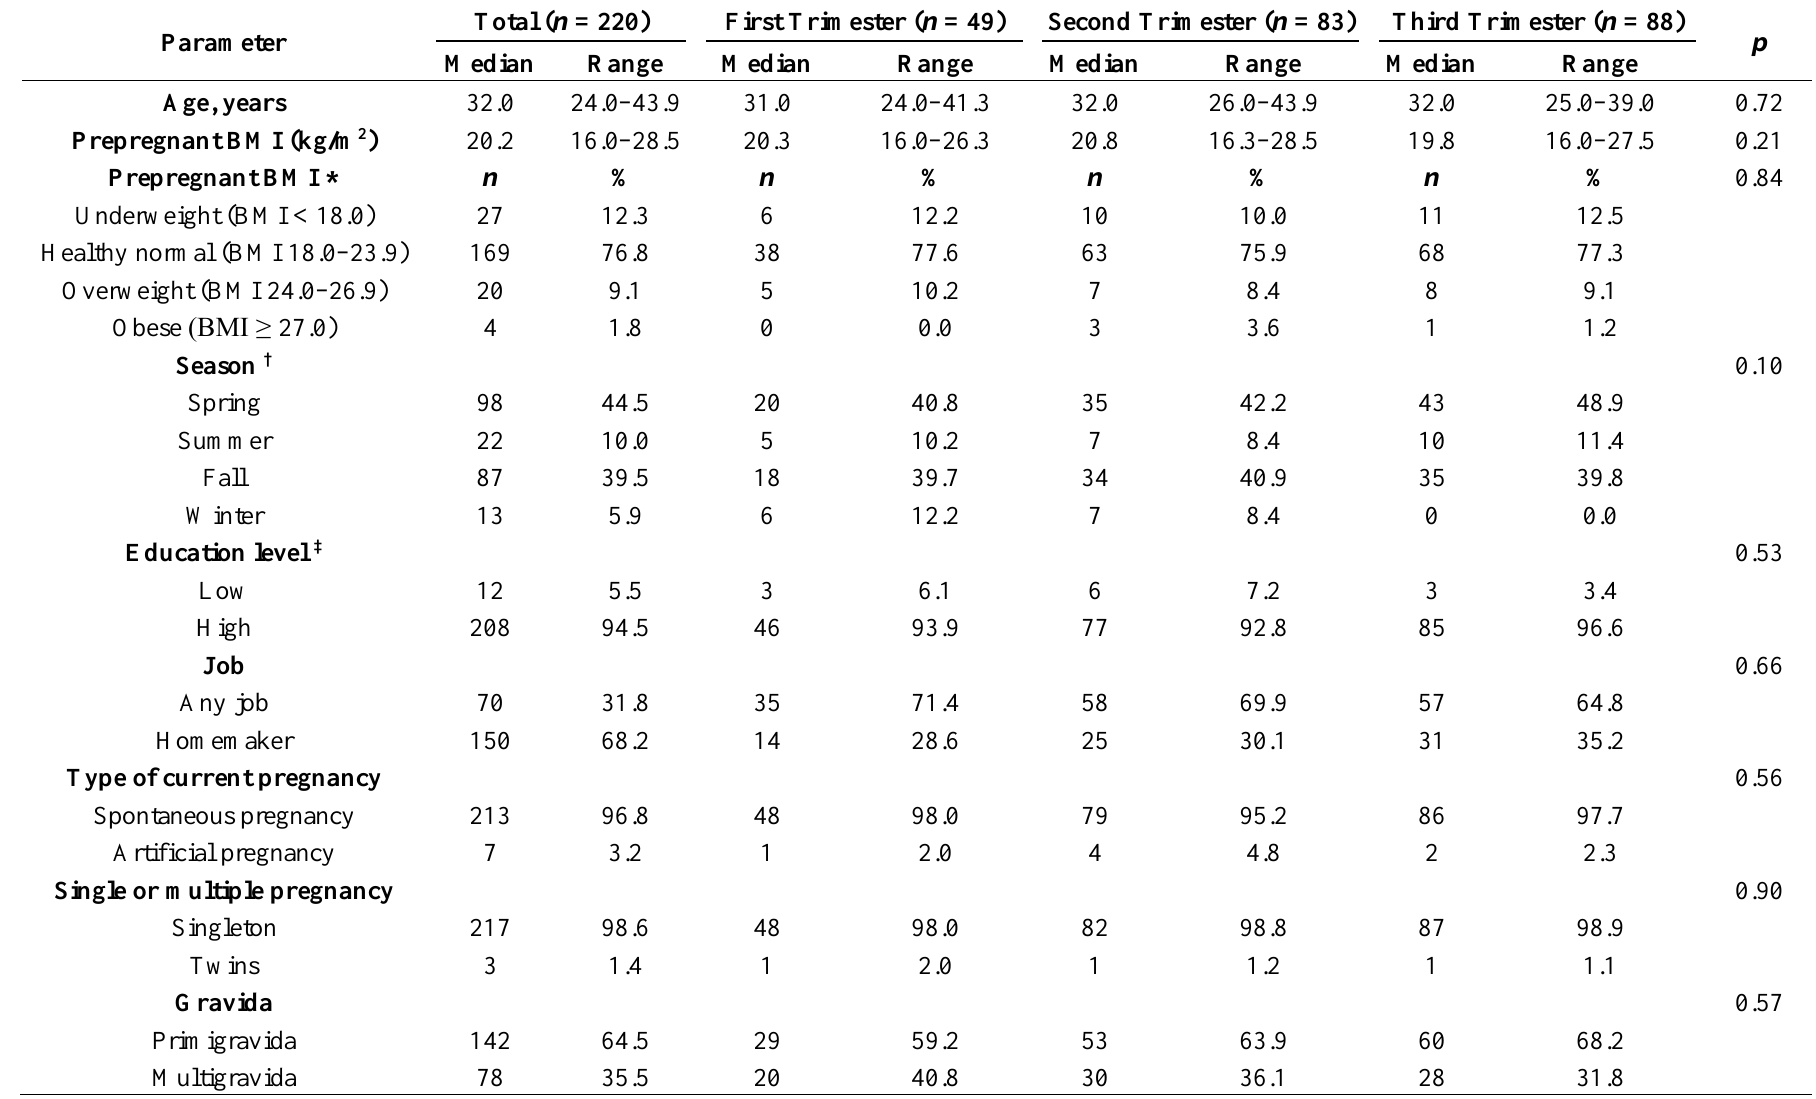
Table 1. Basic parameters of pregnant Korean women ( n =